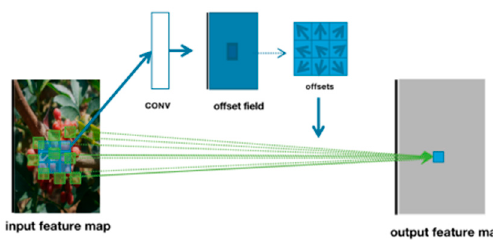
Figure 6. Deformable convolutional structure.